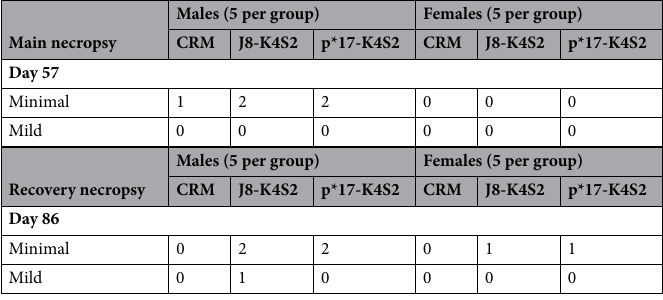
Table 3. Observed cardiomyopathy.